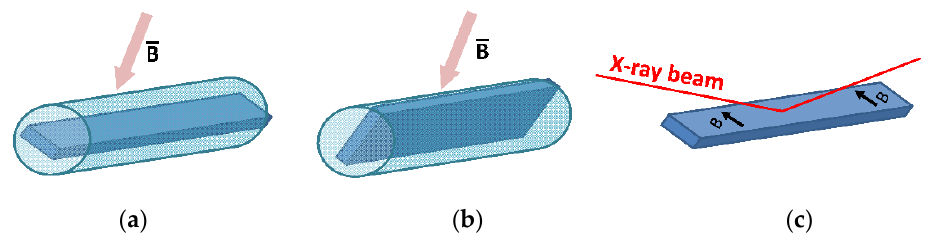
Figure 1. Schematic of the sample orientation in the capillary normal ( a ) and parallel ( b ) to the MF (pink arrow); ( c ) Orientation of X-ray beam in respect to MF direction during GIXD measurements.